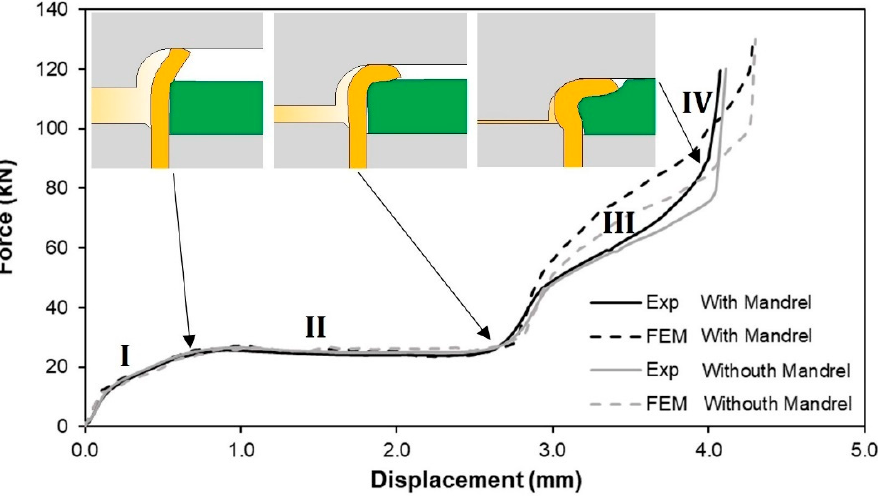
Figure 9. Experimental and finite element predicted evolution of the joining force vs. displacement with and without inner mandrel ( r c = 3 mm, h = 4